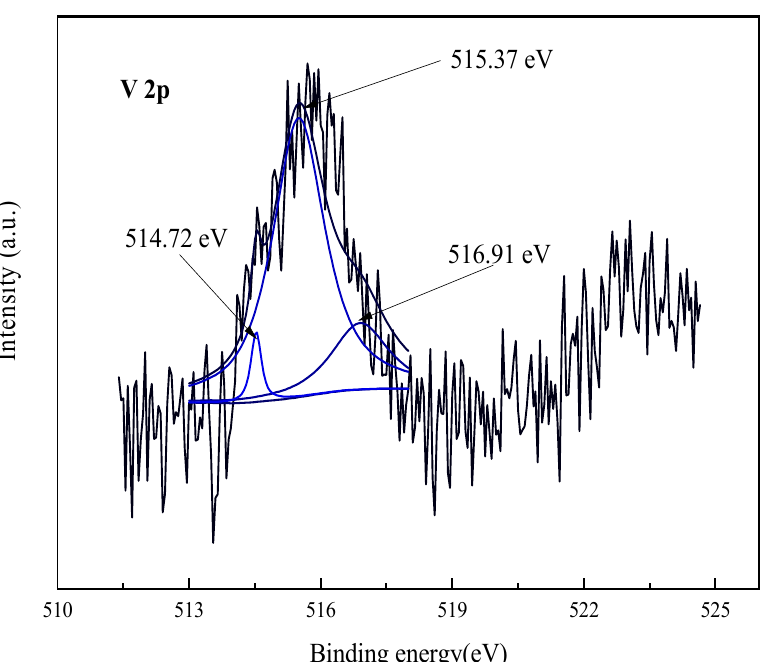
Figure 3. V 2p spectrum of fresh denitration catalyst.